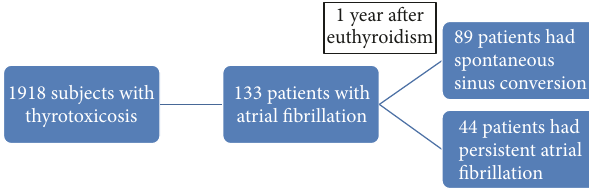
Figure 1: Subjects included in the study.